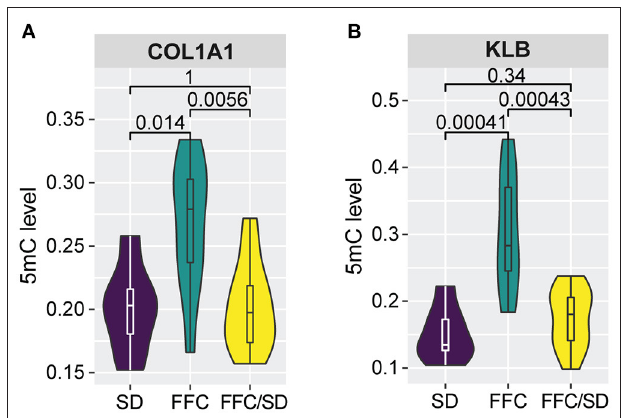
FIGURE 4 | Methylation alterations associated with fibrosis generation. (A,B) Boxplot of methylation level of promoter regions of COL1A1 (A) and KLB (B) . P -values were calculated using Mann-Whitney U